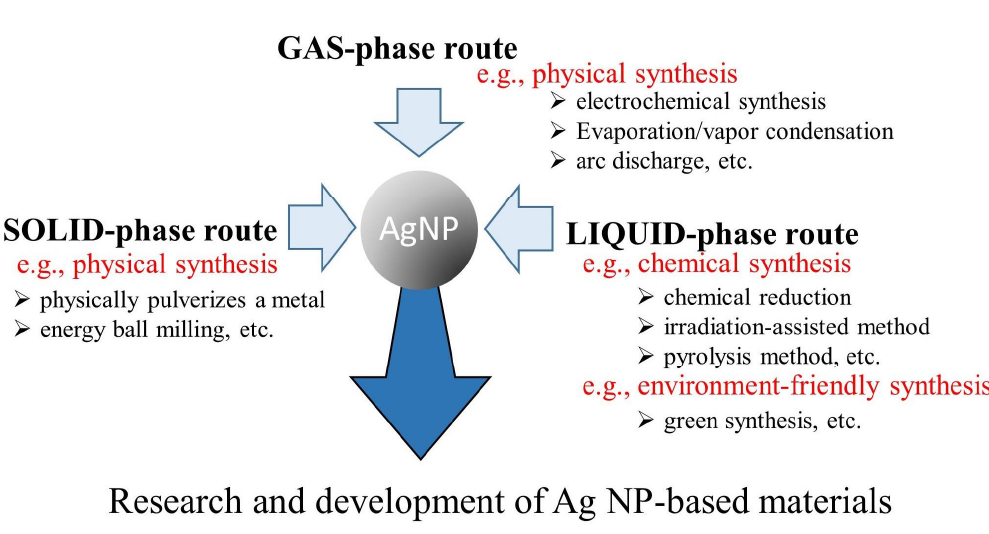
Figure 1. Various methods for silver nanoparticle (Ag NP) synthesis. Ag NPs have been synthesized using various methods that can be classified as solid, liquid, or gas-phase routes.